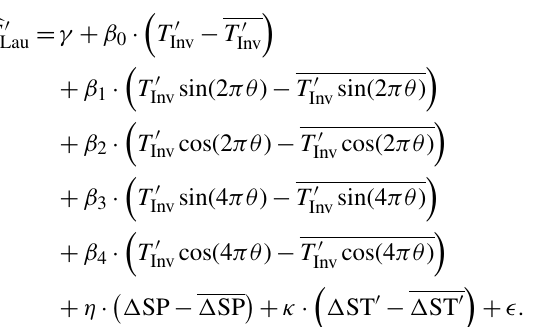
Figure 3. Temperature residuals for the regression model described in Eq. (5). The regression model is trained with three different data sets containing Lauder and Invercargill radiosonde measure- ments with launch times having a maximum time difference of 1.5h (green, 324 collocations), 3h (pink, 646 collocations), and 6h (blue, 879